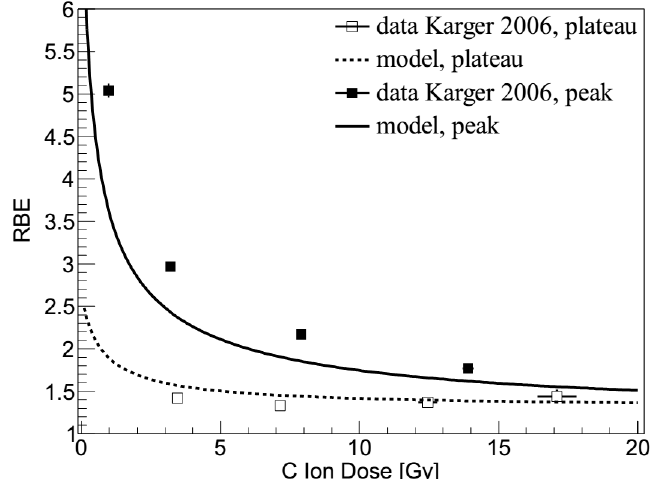
Figure 2. RBE as a function of carbon ion dose for irradiation of the rat spinal cord in the SOBP (upper line and filled data points) or in the entrance plateau (lower line and open data points). The lines are predictions by BIANCA, the points are experimental data taken from [10].